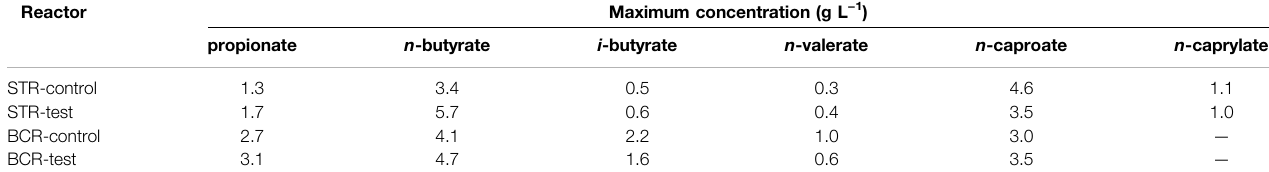
TABLE 1 | Maximum concentration of carboxylates achieved in the experiments.